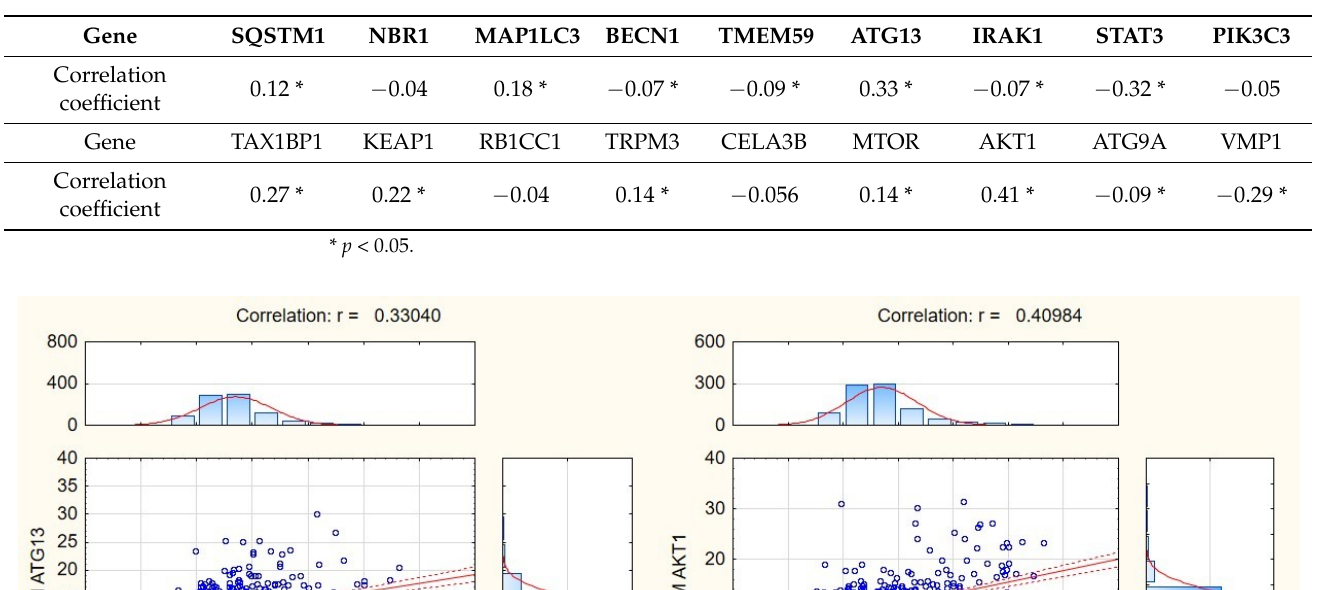
Table 3. Correlations between the expression of autophagy-associated genes and TOLLIP [16–32].